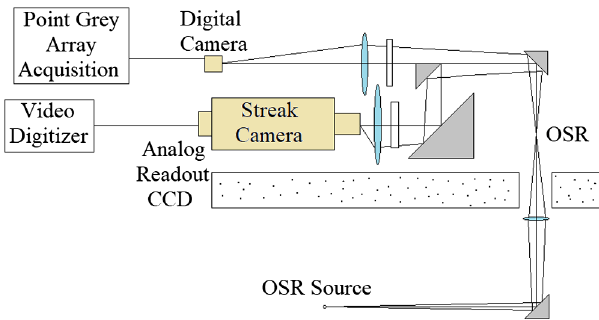
FIG. 2. Schematic illustration of the PAR West optics table with the digital CMOS camera and the streak camera [19].